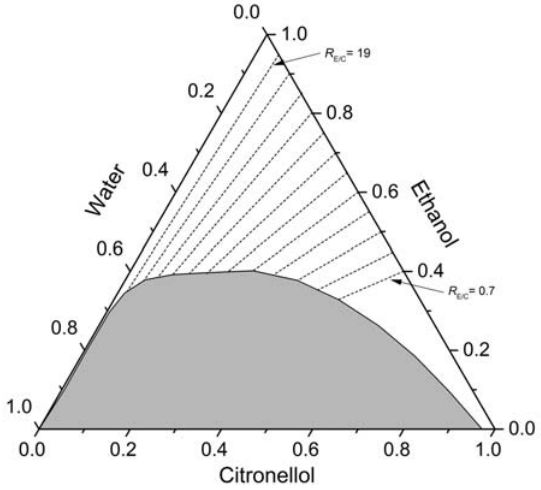
Figure 1. Ternary phase diagram of water/ethanol/citronellol mix- tures at 25 °C. The white region represents compositions of monop- hasic, clear, macroscopically homogeneous mixtures, the dark re- gion represents compositions of two-phase systems. The values are given in mass fraction. The original diagram is taken from Ref. [9]. The various experimental paths at different ( R 19 to 0.7, along which the conductivity measurements were per- formed, are drawn as dashed